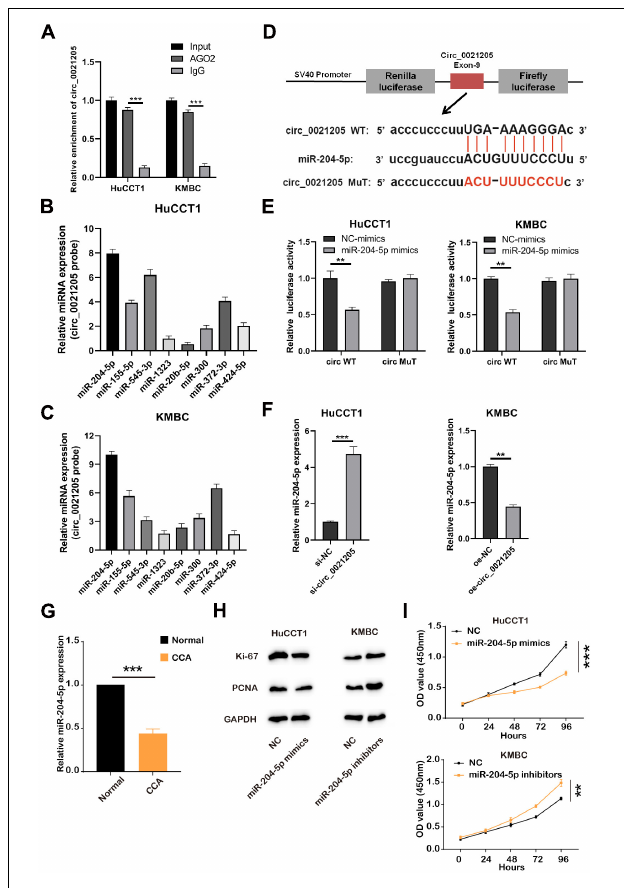
FIGURE 3 | Circ_0021205 serves as a miR-204-5p sponge. (A) RIP experiments with AGO2 antibody were conducted, the expression of circ_0021205 was detected using qRT-PCR. (B,C) The expression of miRNAs bind to circ_0021205 probes in HuCCT1 and KMBC cells was detected by qRT-PCR. (D) Schematic illustration of circ_0021205-WT and circ_0021205-MuT luciferase reporter vectors and the binding sites between circ_0021205 and miR-204-5p. (E) The relative luciferase activities were detected in HuCCT1 and KMBC cells after co-transfection with circ_0021205-WT/MuT and miR-204-5p mimics/NC-mimics, respectively. (F) The expression of miR-204-5p was detected in HuCCT1 and KMBC cells transfected with si-circ_0021205 and OE-circ_0021205 plasmids, respectively. (G) Relative expression of miR-204-5p was detected in CCA and normal tissues. (H) The levels of proliferation makers, Ki-67 and PCNA, were investigated using western blotting. (I) The proliferation of transfected CCA cells was determined by CCK-8 assay. All experiments were repeated at least three time. ** P < 0.01, *** P <